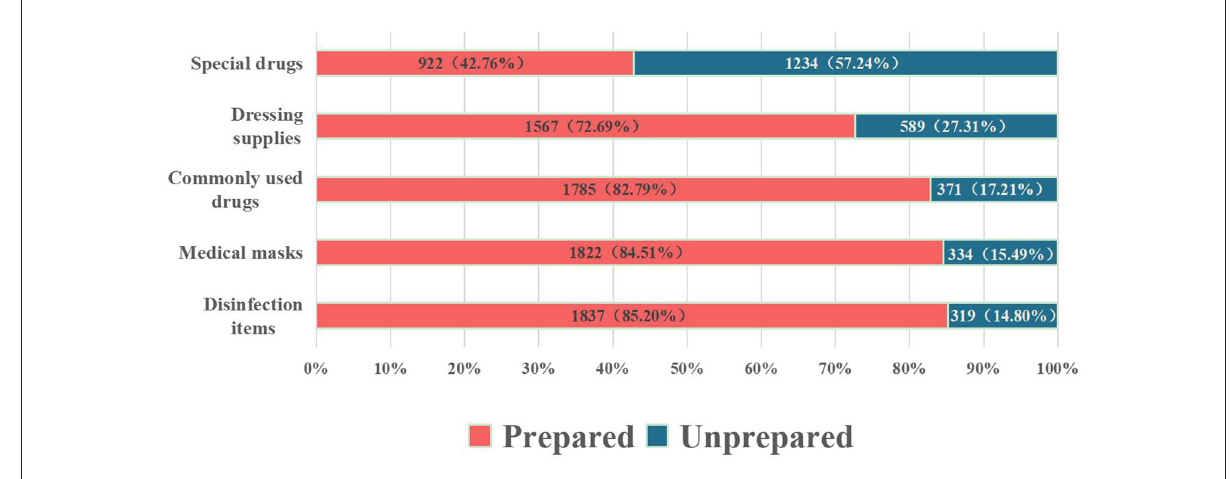
FIGURE4 Preparation of items in respondents’ home first aid